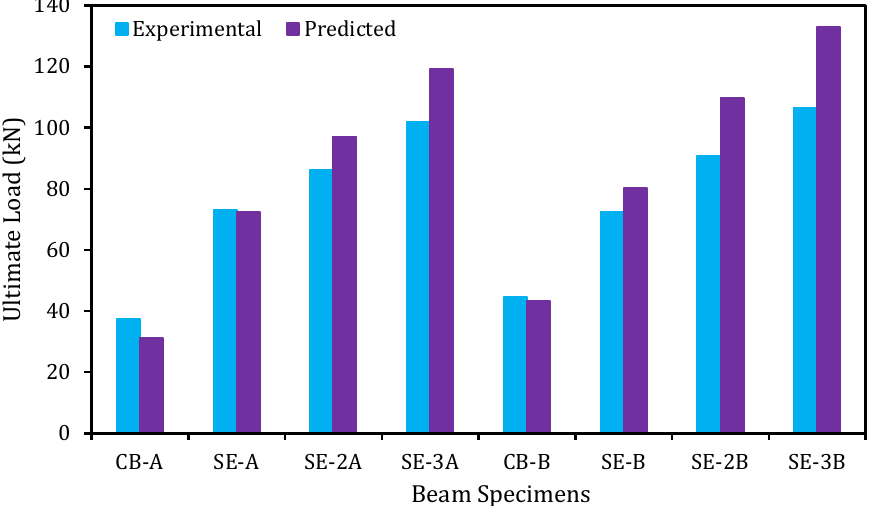
Figure 13. Experimental and predicted yield load comparison.